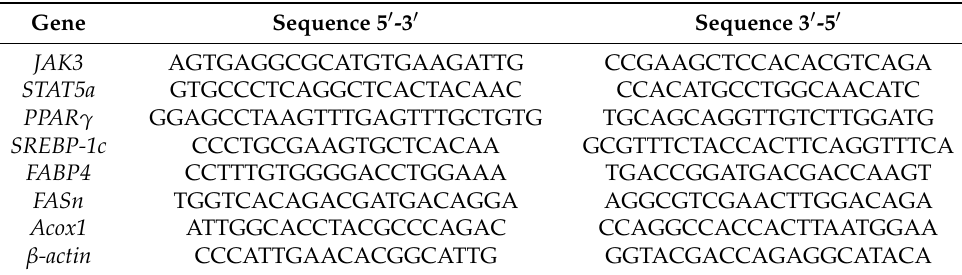
Table 1. Real time quantitative PCR